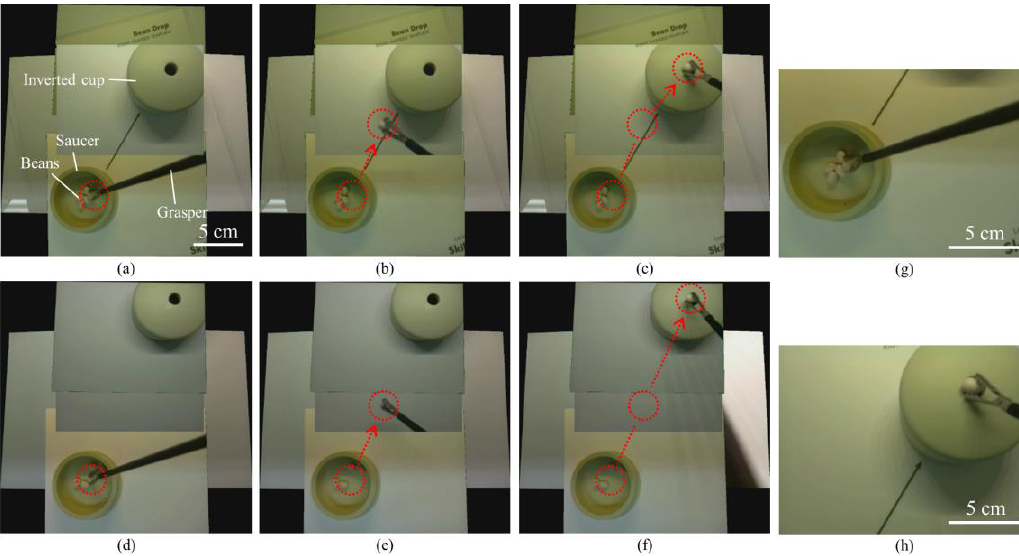
Figure 7. Captured images from a real-time stitched video during a standard bean drop task in the simulator box by using the TCA ( a – c ), and a standard bean drop task with longer moving distance and without an arrow mark ( d – f ). We successfully performed a standard bean drop task by using the real-time stitched video without any physical camera maneuver. The red dotted circles and arrows in each figure show initial and end positions, and the trajectories of the moving beans grasped by a grasper. ( g , h ) The images from two single cameras show that a single camera cannot cover the saucer and the inverted cup simultaneously.